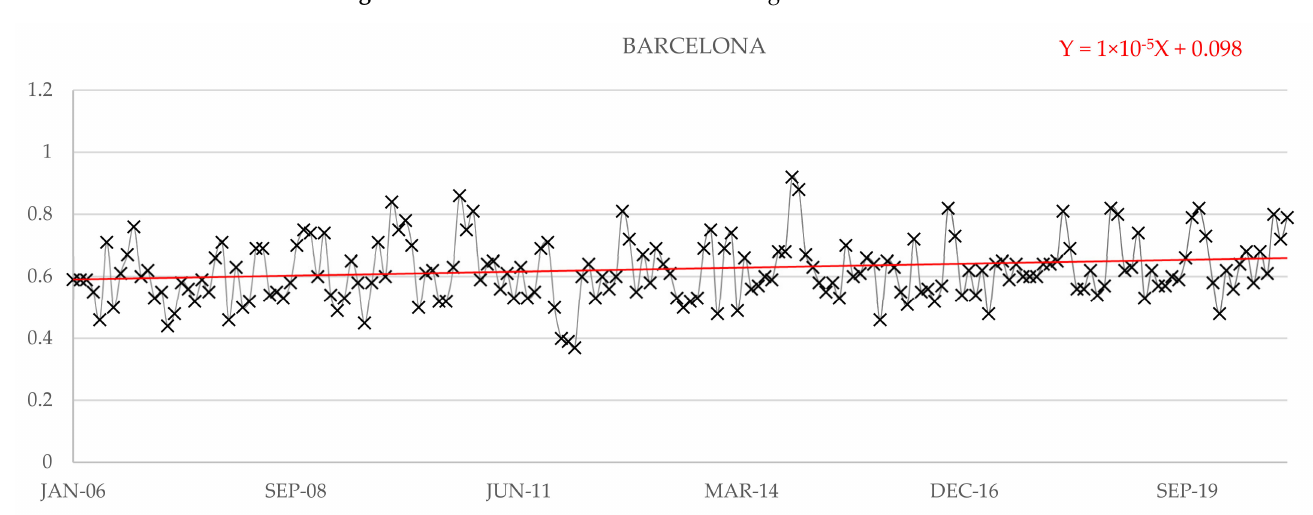
Figure 39. Evolution of SL maxima in Tarragona from 2011 to 2020.